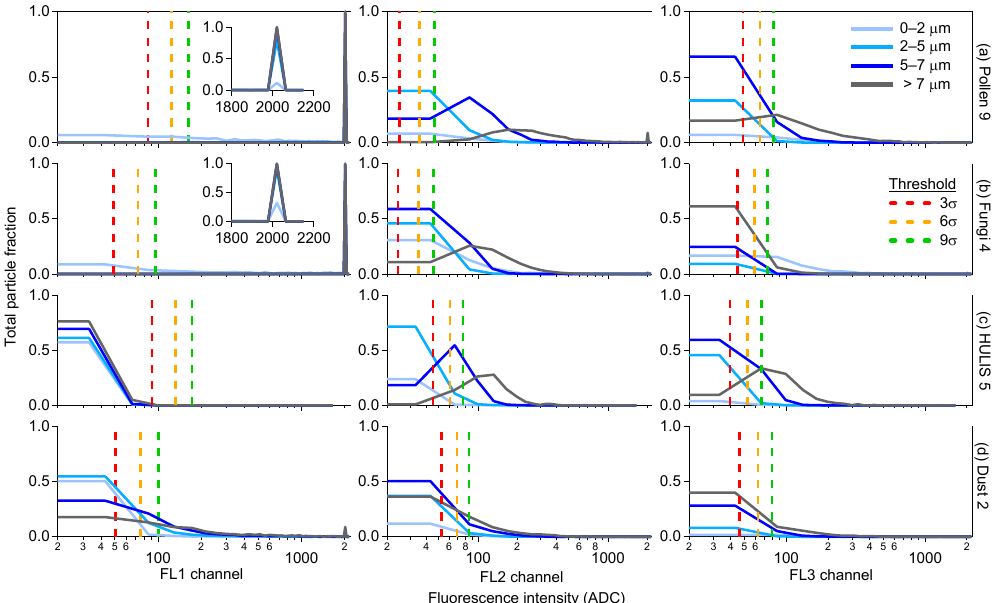
Figure 4. Relative fraction of fluorescent particles versus fluorescence intensity in analog-to-digital counts (ADC) for each channel. Particles are binned into four different size ranges (trace colors). Vertical lines indicate three thresholding definitions. Insets shown for particles that exhibit fluorescence saturation